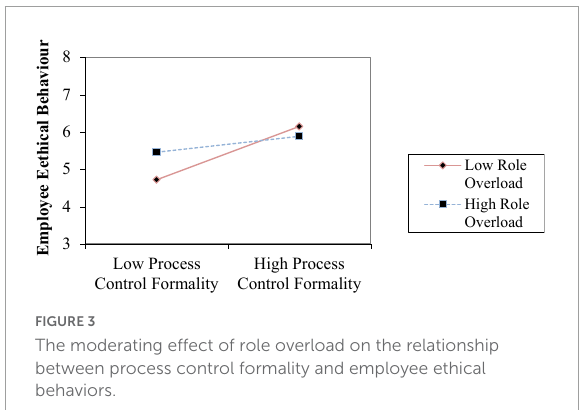
FIGURE3 The moderating effect of role overload on the relationship between process control formality and employee ethical behaviors.